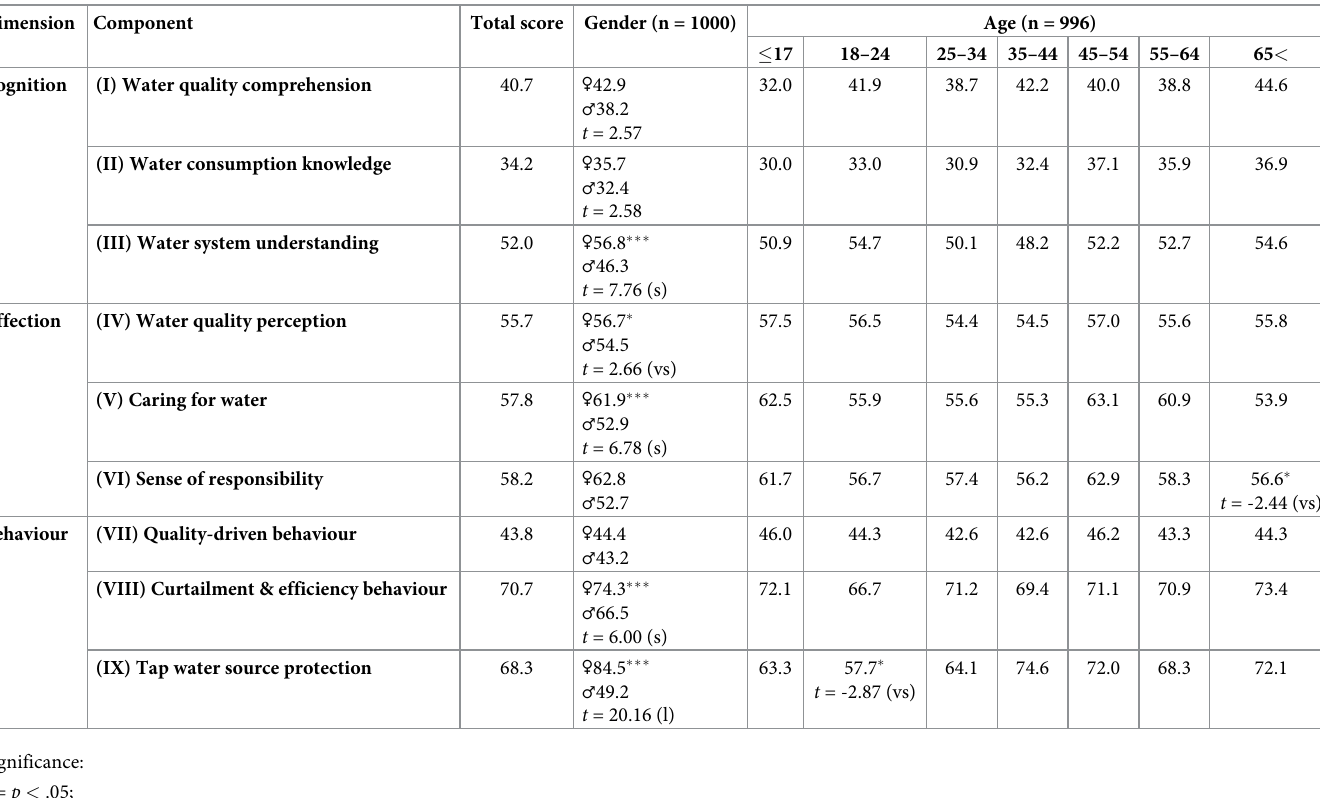
Table 5. Customer component awareness scores—Gender and age. Dimension